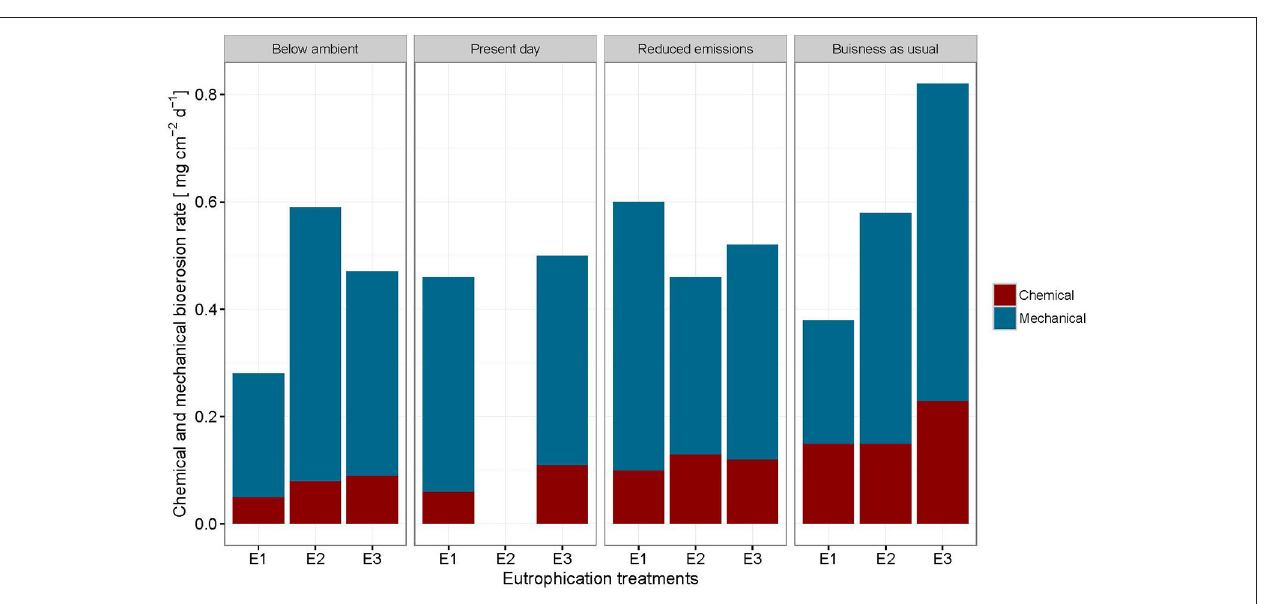
FIGURE 5 | Sum of chemical and mechanical bioerosion in mg cm − 2 d − 1 for each p CO 2 and eutrophication scenario. Mechanical bioerosion rates were estimated using the weight of chips collected during 6h incubations. Chips were only collected for table A and B during the day and night ( N = 44).Chemical bioerosion rates were calculated from ∆ A T in incubations ( N = 59). Day (24h) rates were calculated by multiplying day and night mechanical and chemical hourly rates by 12 and adding them together for each p CO 2 and eutrophication